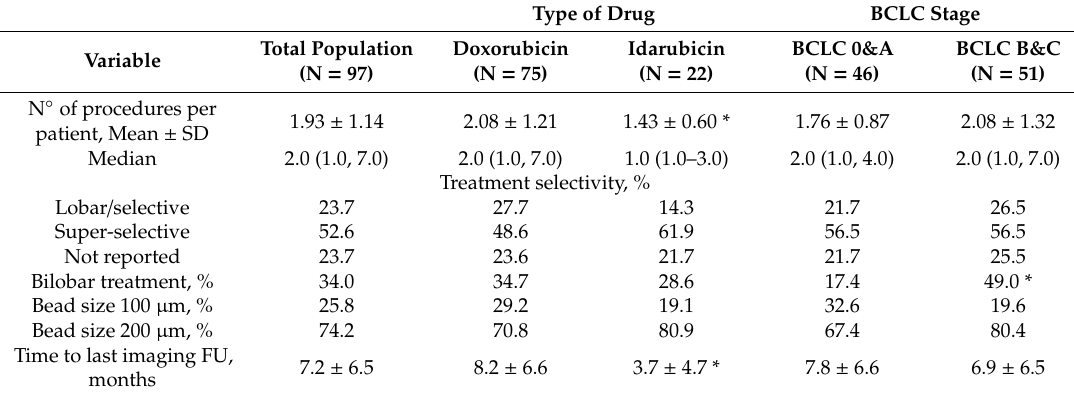
Table 2. Procedure characteristics.